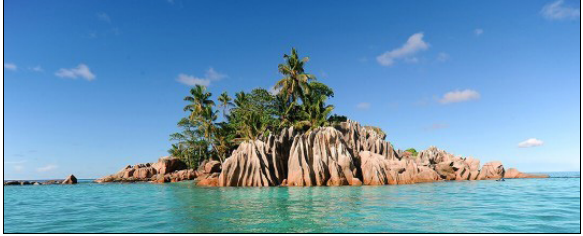
Source: Hotel La Roussette; reproduced with permission Strongly fluted outcrops of granite, due to wetting caused by dripping of vegetation or guidance of rain down incipient fluting, as observed by du Toit on Mahé